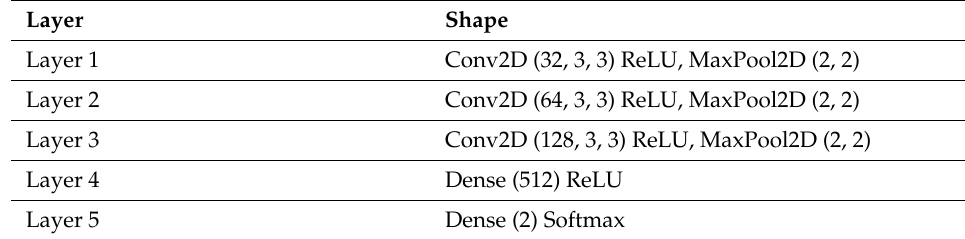
Table 5. Parameters settings for the